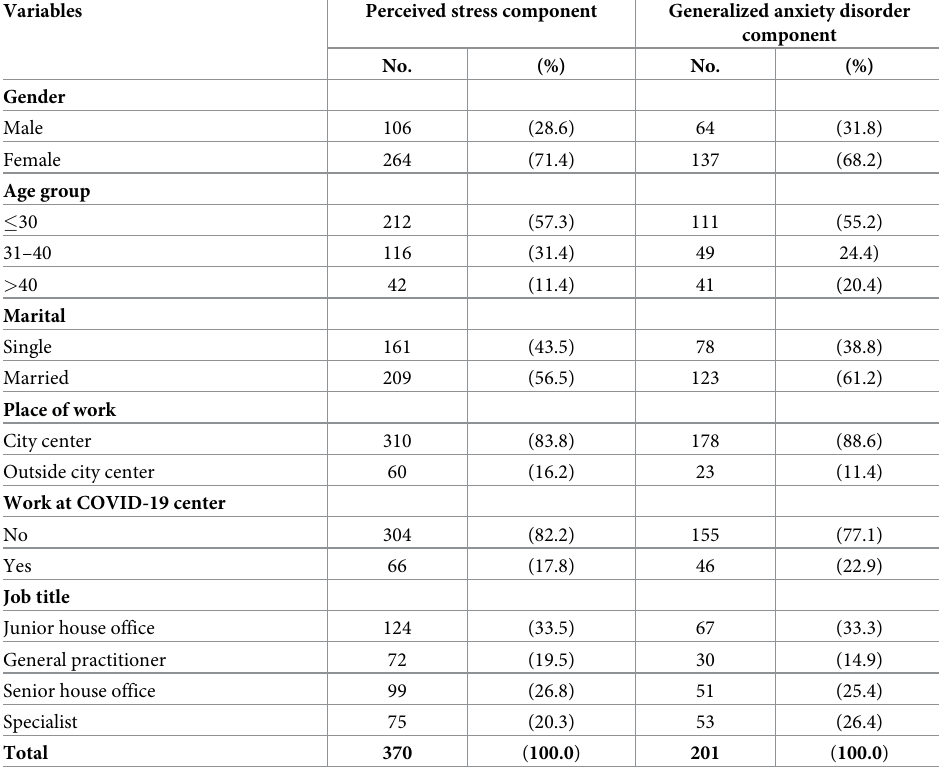
Table 1. Demographic and professional characteristics of the participants.